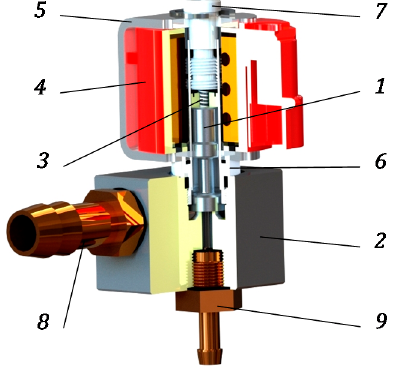
Figure 1. Valtek Rail Type-30 gas injector: 1— plunger; 2— corps; 3— spring; 4— coil; 5— cramp; 6— pilot; 7— limiter; 8— inlet nozzle; and 9— outlet nozzle.